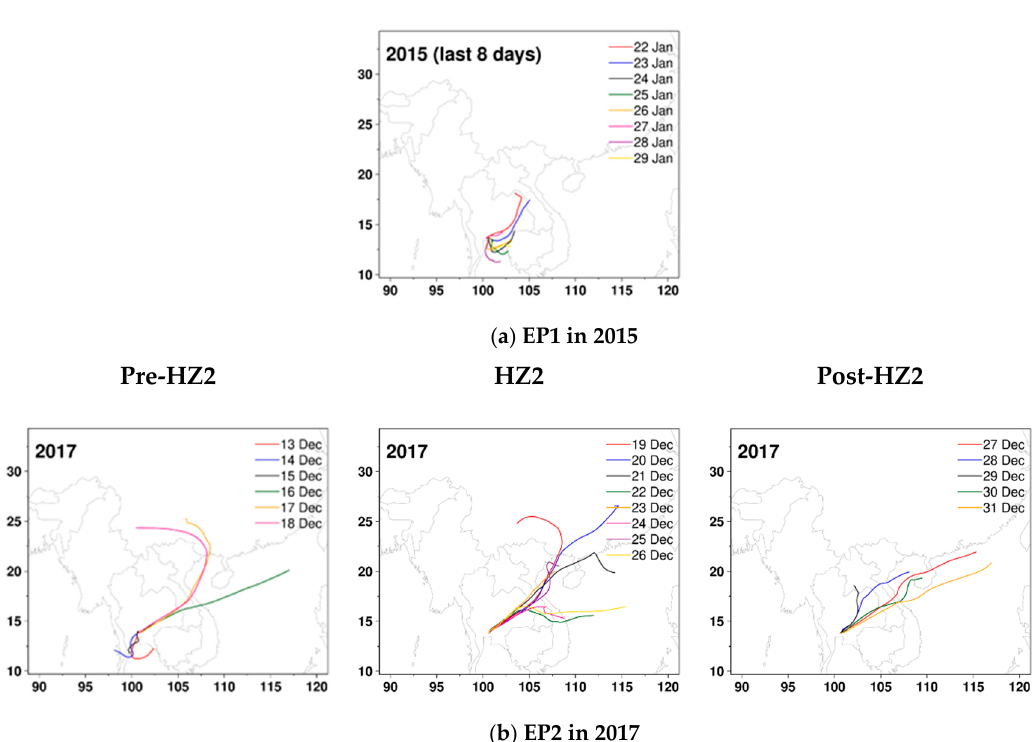
Figure 5. Daily 48-h back-trajectories: ( a ) EP1 in 2015; ( b ) EP2 in 2017.